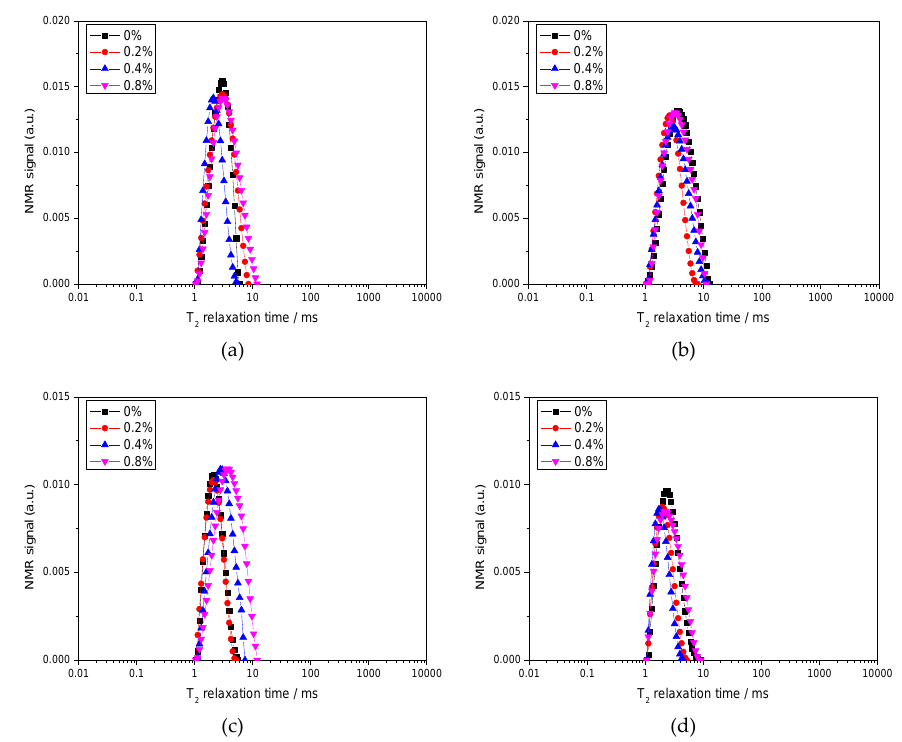
Figure 9. The long-duration T 2 relaxation time of CPB mixture with different polynaphtalene sulfonate dosages when the hydration time is: ( a ) 1 d, ( b ) 7 d, ( c ) 14 d, and ( d ) 28